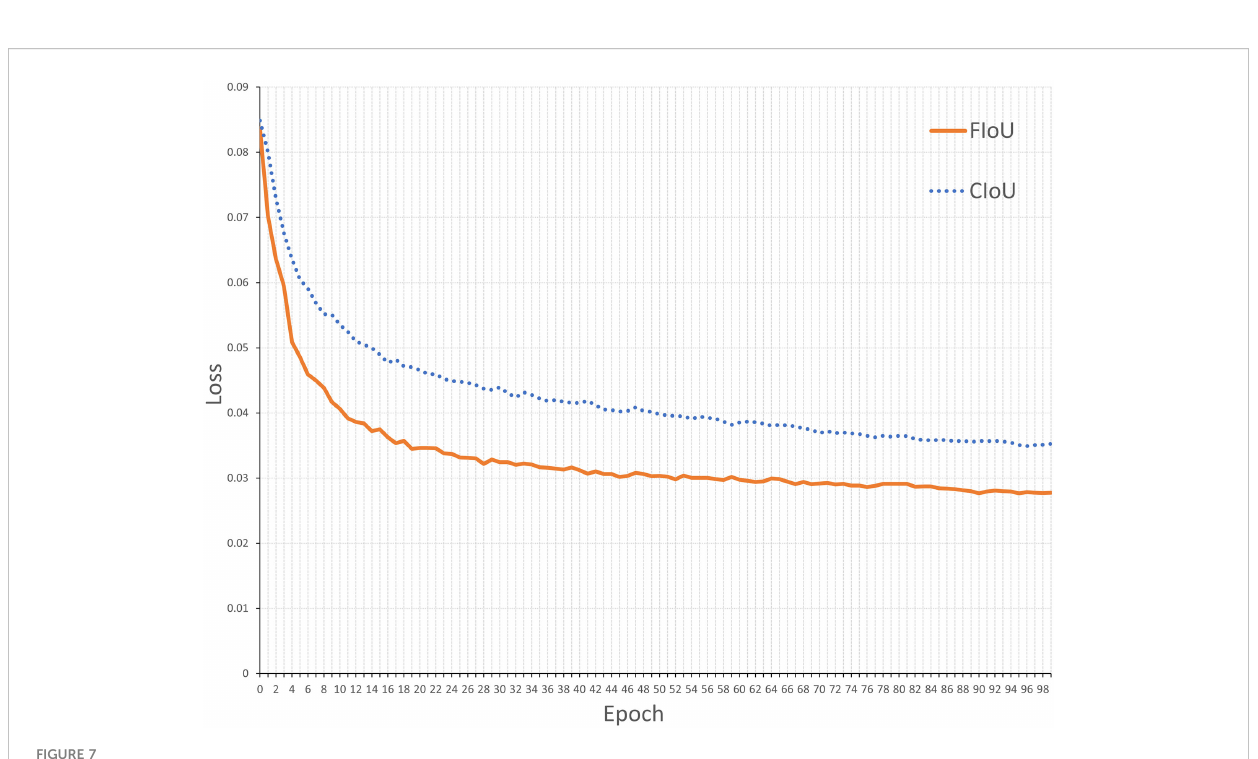
FIGURE 7 Curves of the FIoU and CIoU loss values with the epoch